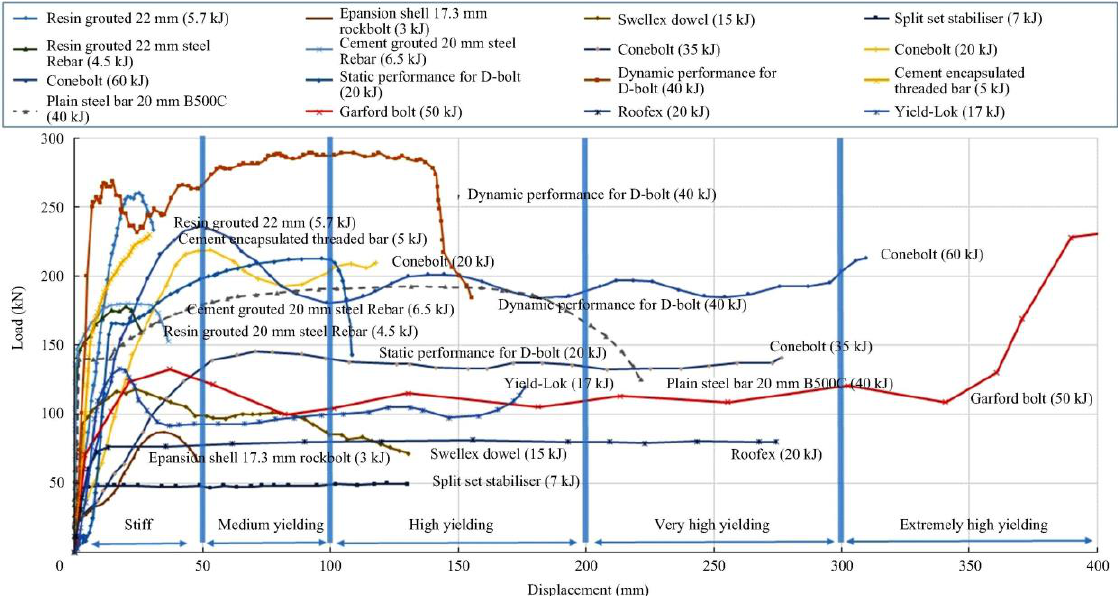
Figure 15. Load-displacement behavior of different types of rockbolts [199].